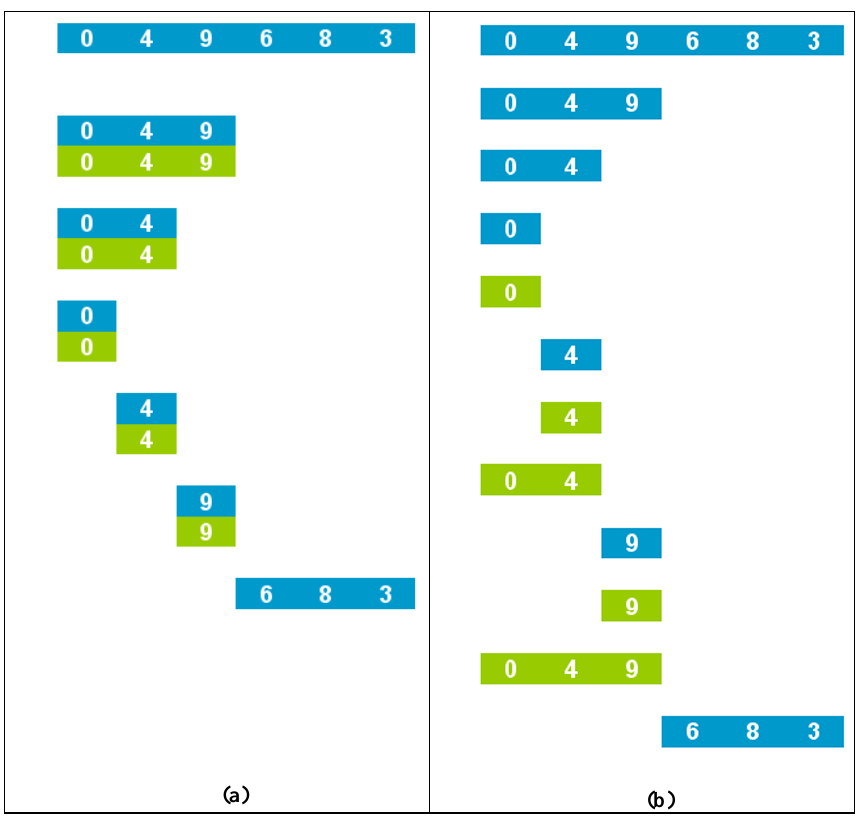
Figure 7. Two rearrangements of a sequence of array states for